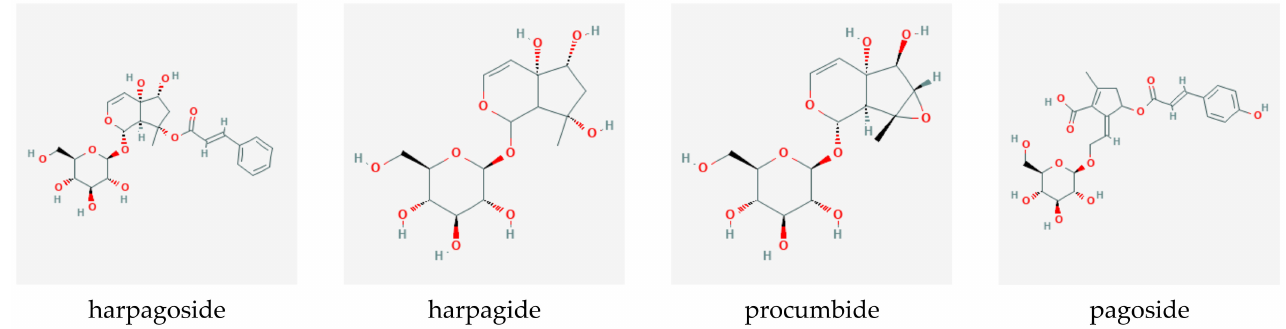
Figure 7. Iridoid glucosides present in devil’s claw root (source